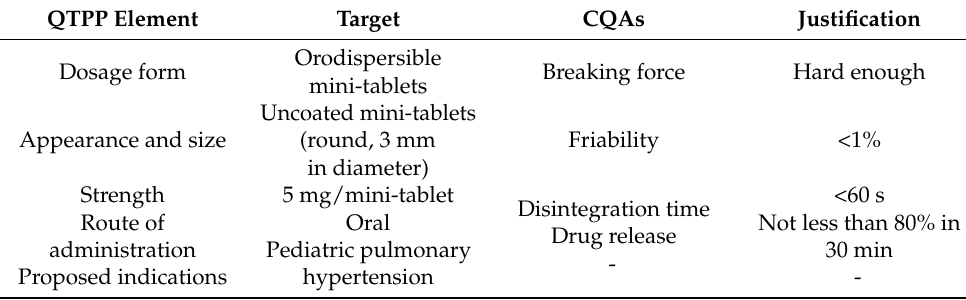
Table 1. QTPP and CQAs of sildenafil MODTs.